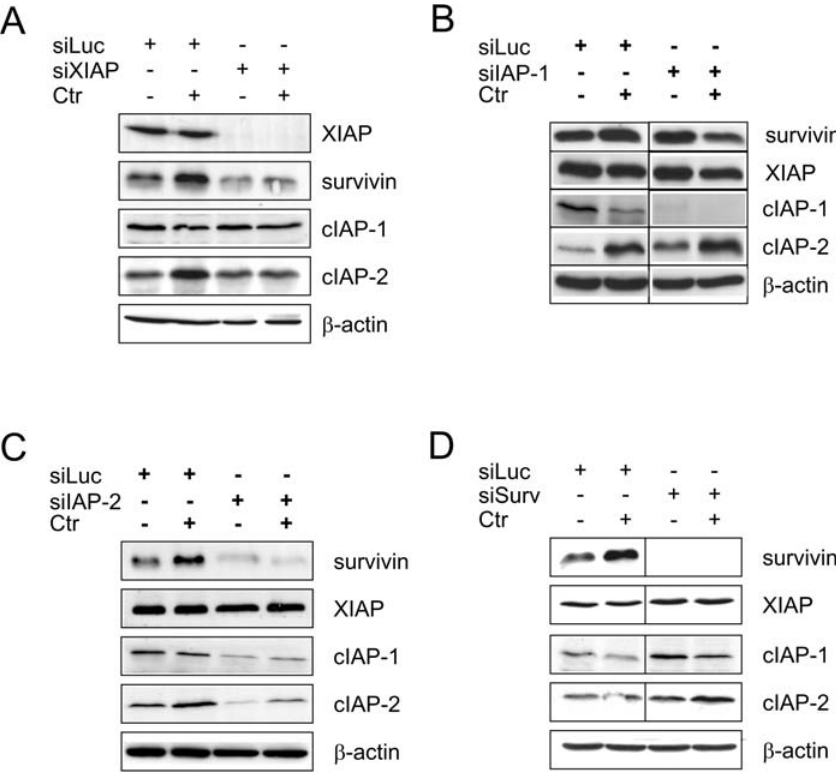
Figure 5. IAPs Cross-Regulate Each Other siRNAs directed against (A) luciferase or XIAP, (B) cIAP-1, (C) cIAP-2, or (D) survivin were transfected in HeLa cells, and the protein levels of all IAPs were determined in infected ( þ ) or uninfected ( (cid:1) ) samples by immunoblot analysis as